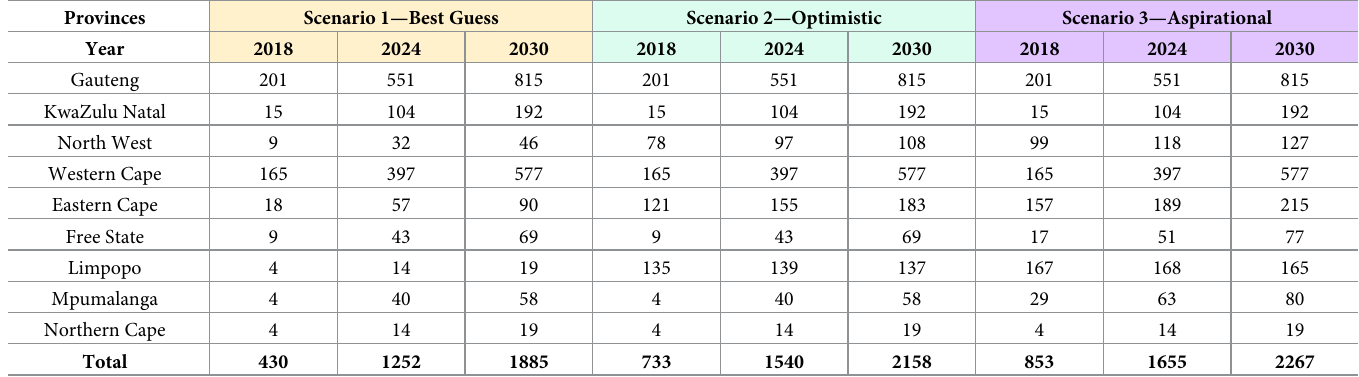
Table 4. National shortfall for dentists and dental specialists based on three scenarios (up to 2030).